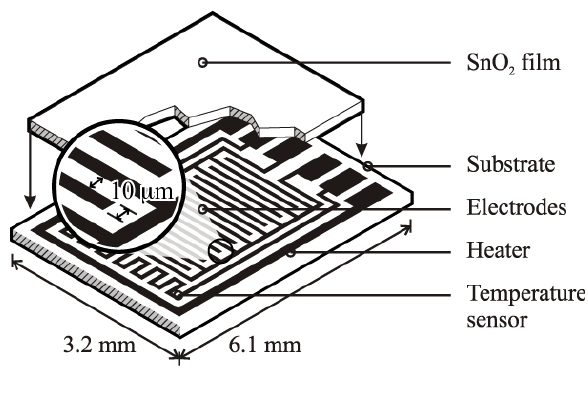
Figure 2. Schematic of the sensor platform (Heraeus MSP 632). The sensing and heating circuits are not drawn to